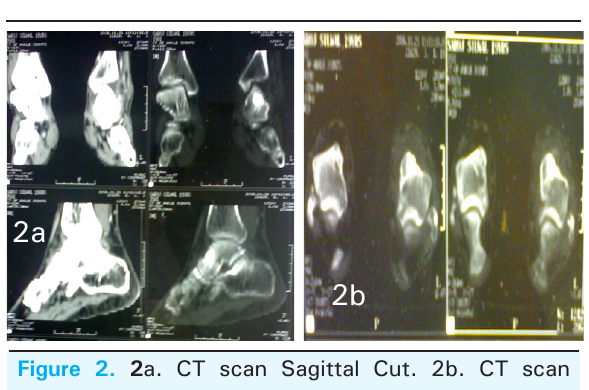
figure 2. 2 a. CT scan Sagittal Cut. 2b. CT scan